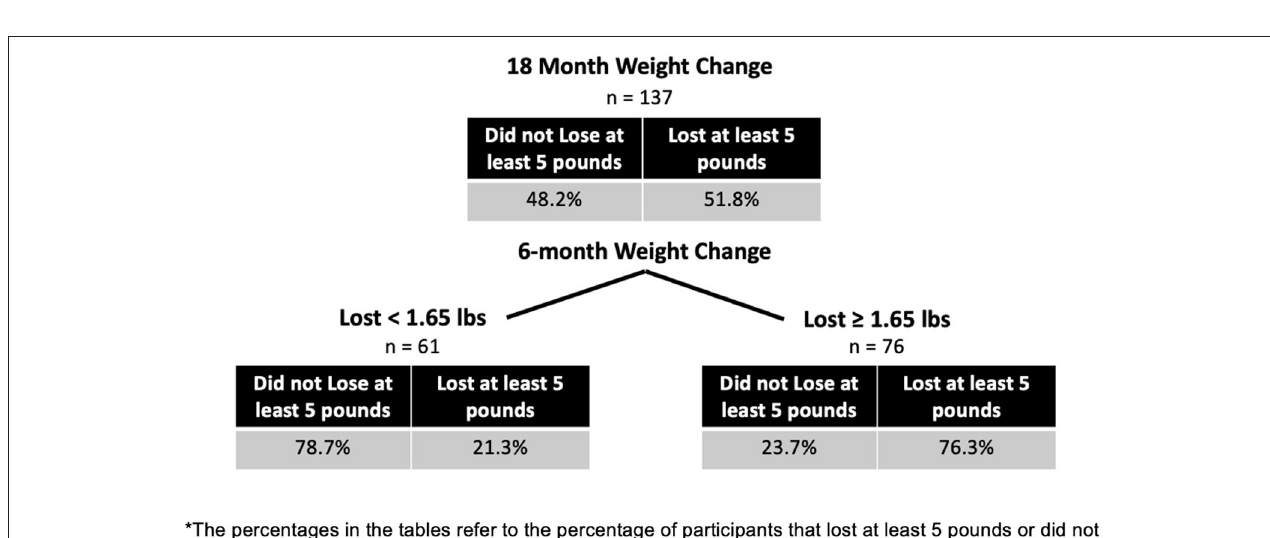
FIGURE 1 | Participants in each category of 6-month weight change and 18-month weight change.